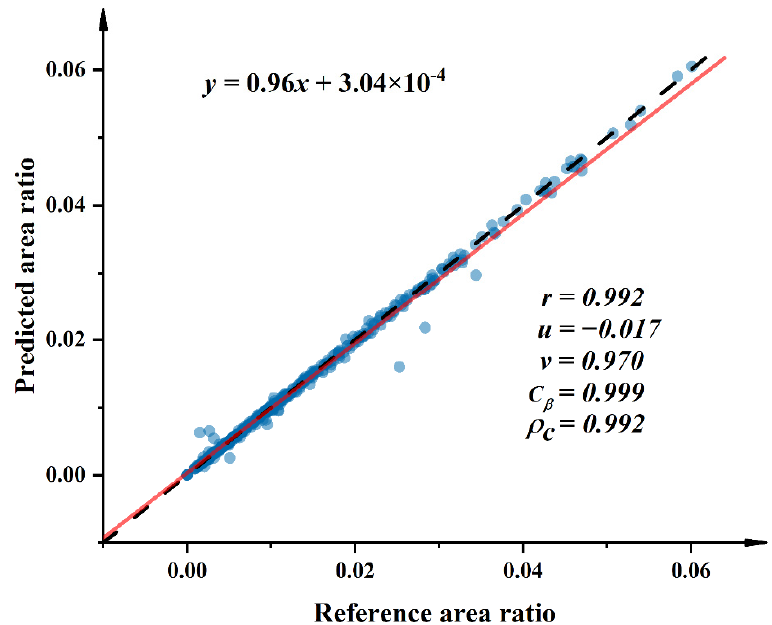
Figure 8. Scatter plot of the relationship between predicted values calculated from the PSPNet and UNet models at the pixel level and the reference value of the area ratio obtained by manually annotating each pixel of the image on the same leaf. The black dashed line (45 ◦ , where slope = 1 and intercept = 0) indicates the line of perfect agreement. The solid red line indicates the best–fit first–order regret line. These statistics represent the Lin’s correlation coefficient analysis within the 95% confidence interval.